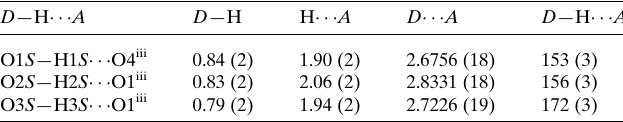
Table 2 Hydrogen-bond geometry (A˚ , (cid:4)